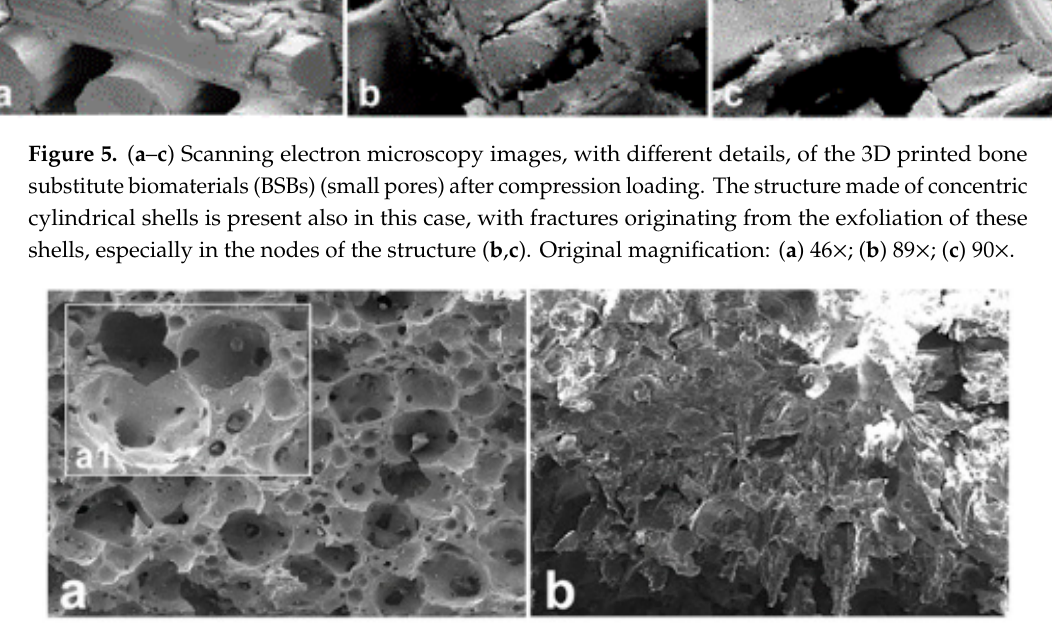
Figure 6. SEM micrographs of a representative sample of the Sintered@ T = 1280 °C group. ( a ) Original microstructure: A network of well-connected pores with di ff erent dimensions. (inset a1 ) Same areas at higher original magnification; ( b ) Fracture surface: Exfoliation after compressive loading with damaged porous network. Original magnification: ( a ) 43 × ; (insert a1 ) 171 × ; ( b ) 26 ×